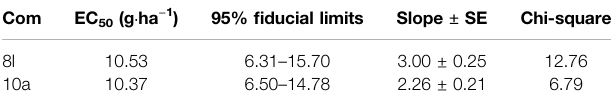
TABLE 2 | EC 50 values of compounds 8l and 10a against barnyard